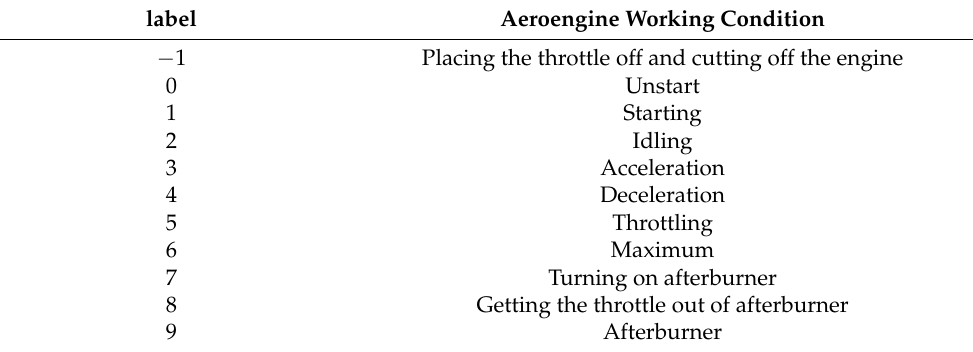
Figure 7. Confusion matrix 2 of working condition recognition. Table 4. The working condition of aeroengine corresponding to the label.